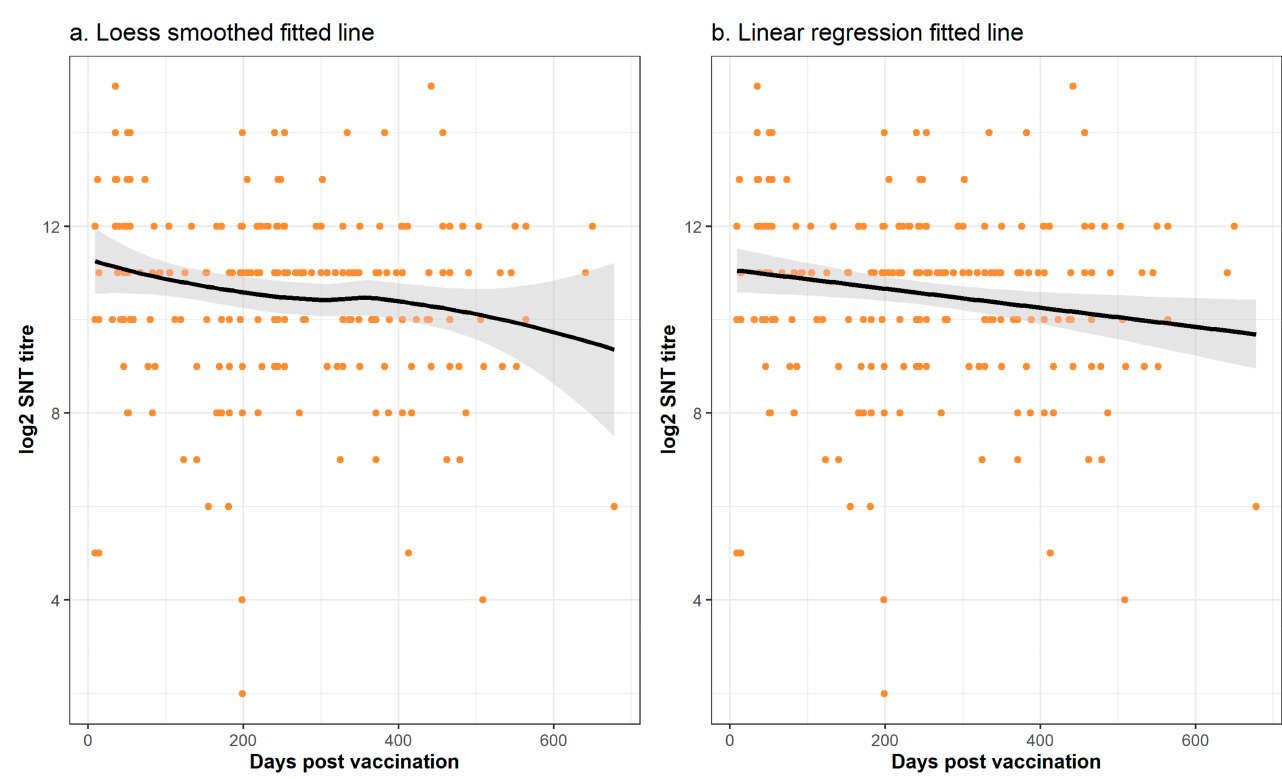
Figure 6. Overall relationship between the time (in days) post-vaccination wherein the serum sample was taken and the measured log2 titre as determined by the serum neutralisation test (SNT) excluding the initial priming regime (vaccinations #1 and 2). Note that whilst the same SNT data are shown in both figures, ( a ) we fit a loess smoothed line whilst in ( b ) we use standard linear regression. For both plots, the grey shading indicates the 95% confidence interval of the fitted lines. There was no significant difference between the loess smoothed and linear regression fitted lines ( p >